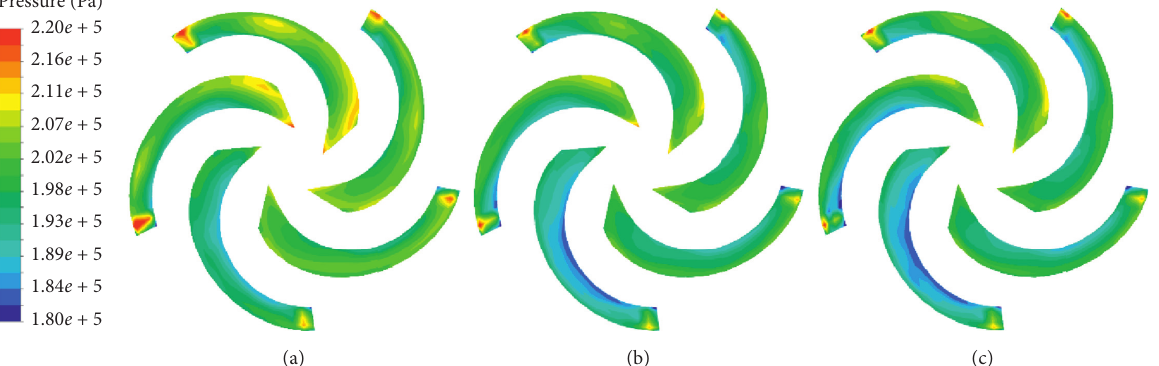
Figure 13: Pressure distribution on the pressure surface of the guide vane: (a) 5mm, (b) 10mm, and (c)